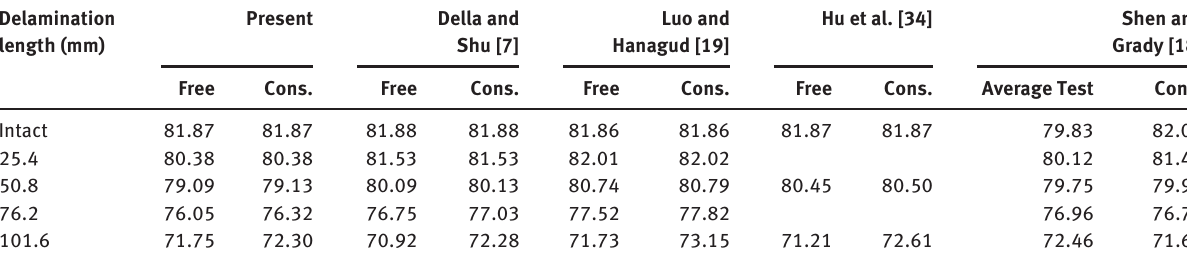
Table 4 Fundamental frequencies (Hz) of the LCB with central delamination located at interface 3.